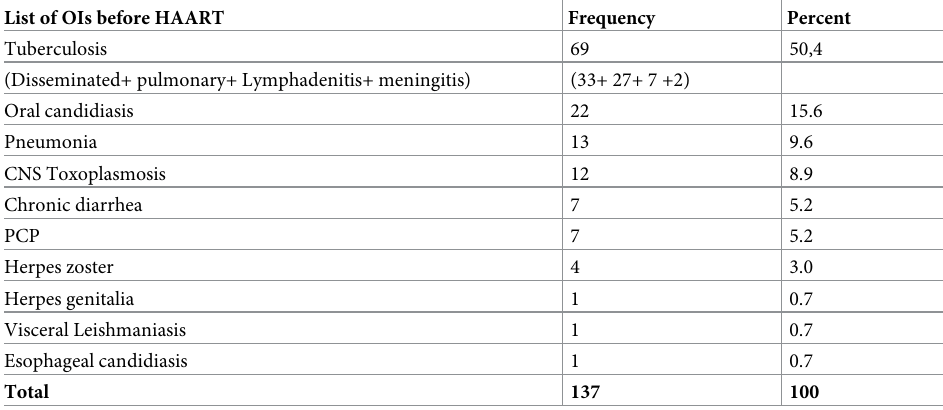
Table 2. Spectrum of HIV related OIs before HAART, at Ayder Referral Hospital, Mekelle, Ethiopia. (n = 317) January 2009 to May 2012. List of OIs before